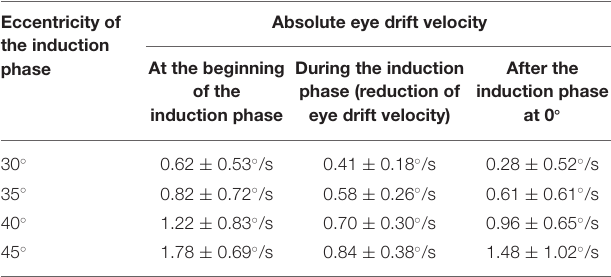
TABLE 1 | Absolute eye drift velocity at the beginning, during and after the induction